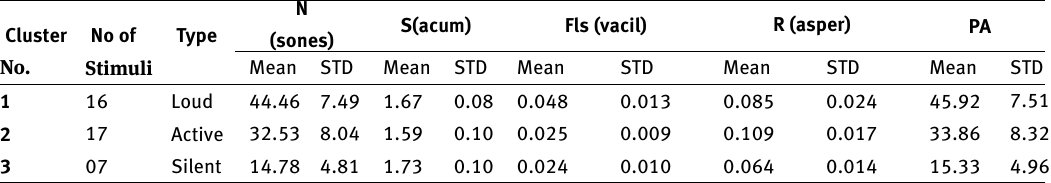
Table 3: Statistical summary of formed clusters